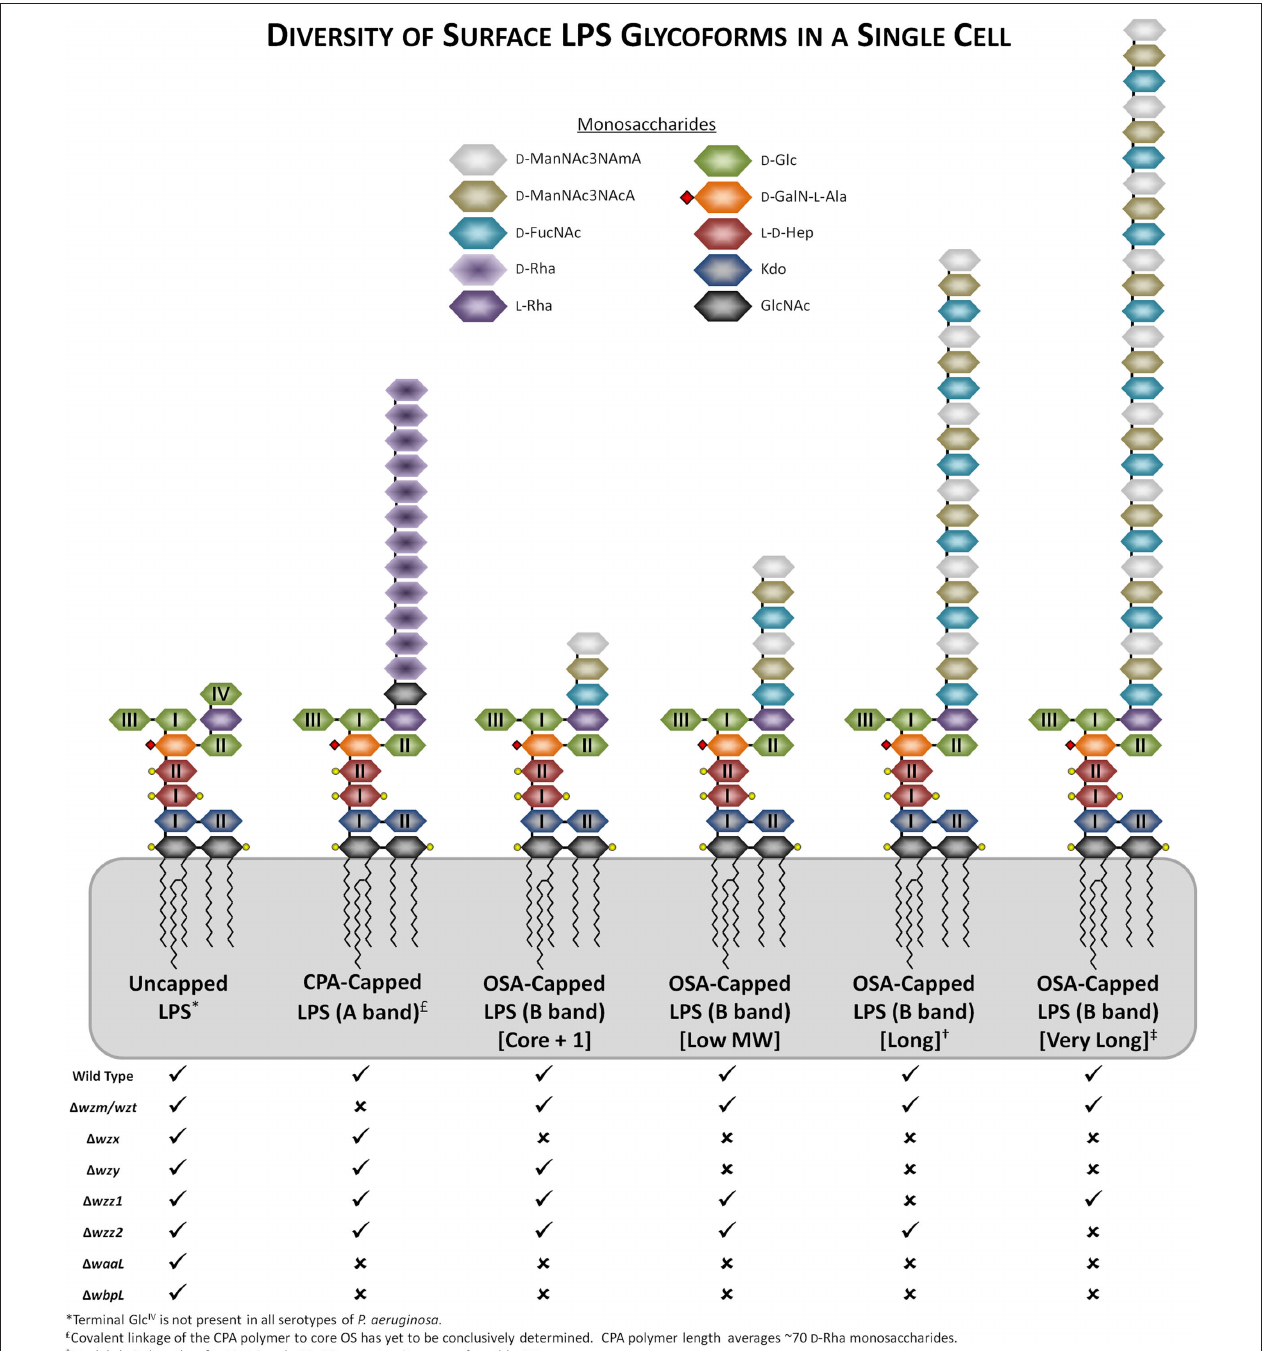
FIgure 1 | representations of the heterogeneity/diversity of the LPS glycoforms present on the surface of a single P. aeruginosa cell. Genetic defects in members of various assembly pathway genes and their resultant changes to the variety of LPS glycoforms present have been indicated, with “  ”